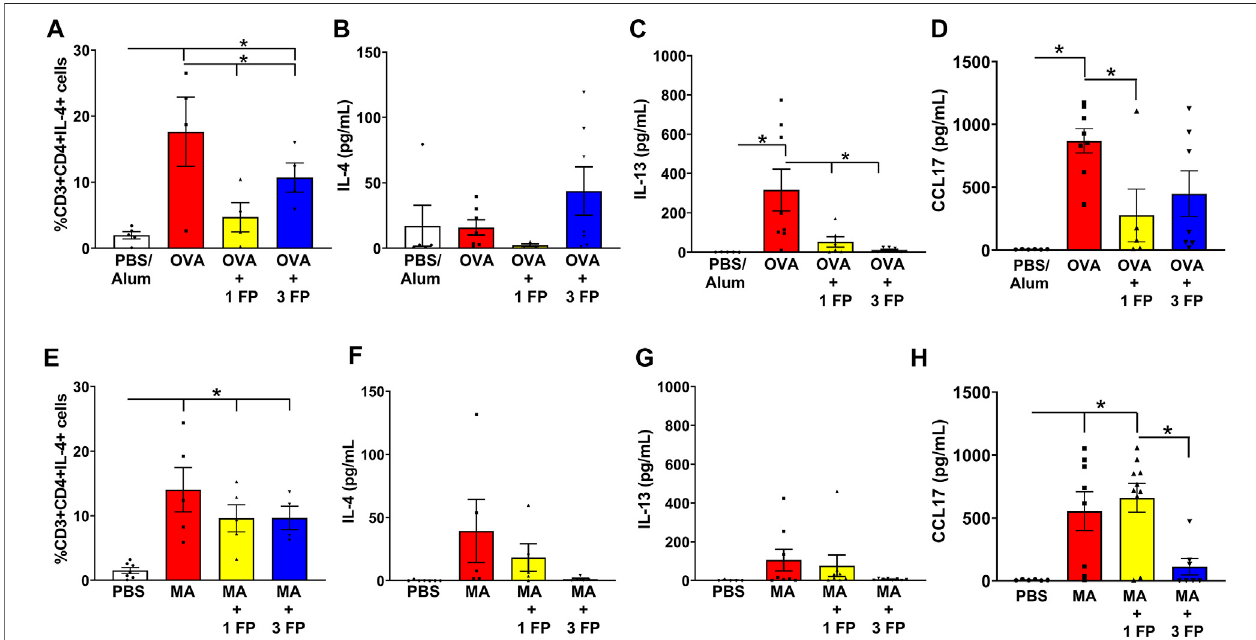
FIGURE6| IL-4 + Th2cellpopulations persistinMA-challenged mice. (A) OVA-and (E) MA-challengedmiceexhibitedsigni fi cantincreases inTh2cellpopulations. (A) Treatmentwith1and 3 mg/kg reducedTh2 cellpopulationsin OVA-challengedmice. (B) BALlevels ofIL-4werenotsigni fi cantlyincreasedinOVA-challenged mice. (C) BAL levels of IL-13 were signi fi cantly increased in OVA-challenged mice and reduced with corticosteroid treatment. (D) Fluticasone reduces CCL17 levels in OVA mice. (E) Treatment of 1 or 3 mg/kg FP did not reduce Th2 cell populations in MA-challenged mice. (F) IL-4 or (G) IL-13 levels trended to be increased in MA- challenged mice. (H) CCL17 levels remain increased MA treated mice administered fl uticasone. Data are presented as ± SEM, n = 4 – 10 mice per group. p < 0.05. * indicates signi fi cant difference between